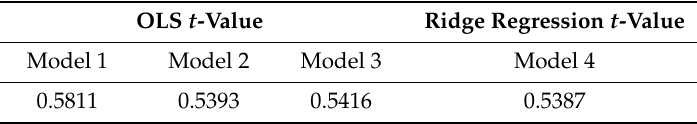
Table 4. Zero mean residual